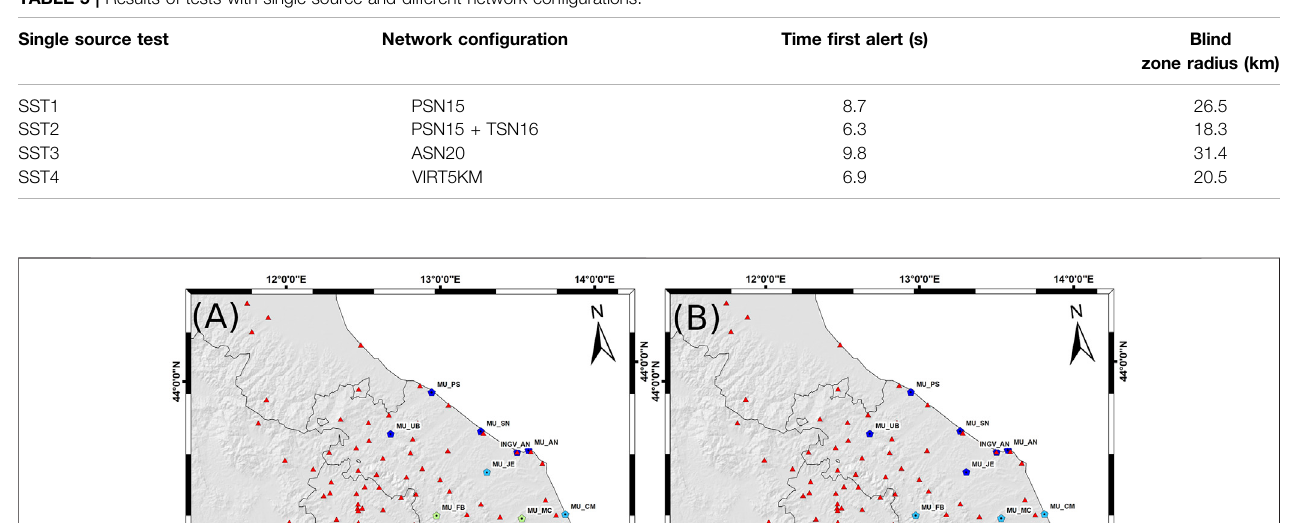
Frontiers in Earth Science |